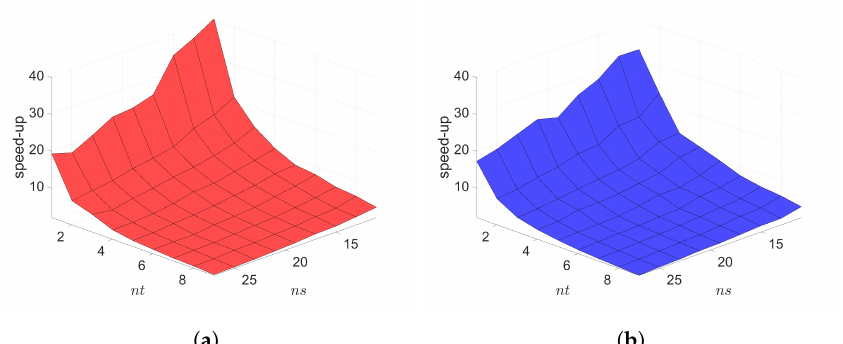
Figure 19. 2D linear convection diffusion equation with source term. Space-time residuals vs. reduced dimensions. Note that the scales of the z -axis, i.e., the residual norm, are the same both for Galerkin and LSPG. Although the LSPG achieves slightly lower minimum residual norm values than the Galerkin, both Galerkin and LSPG show comparable results. ( a ): Space-time residuals vs. reduced dimensions for Galerkin projection, ( b ): Space-time residuals vs. reduced dimensions for LSPG projection.